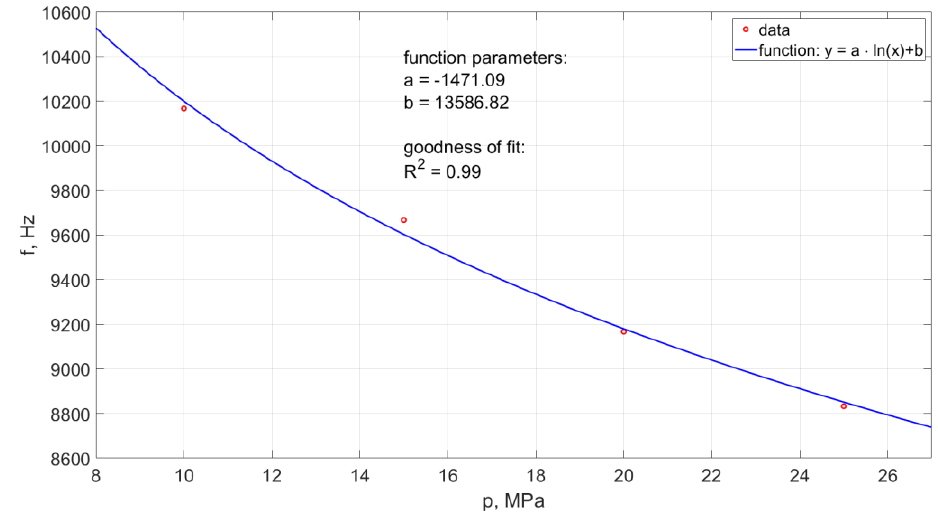
Figure 18. Influence of nominal water pressure on the frequency of pulses recorded with an ultrafast camera, for the head designed for drilling holes working in the air environment.